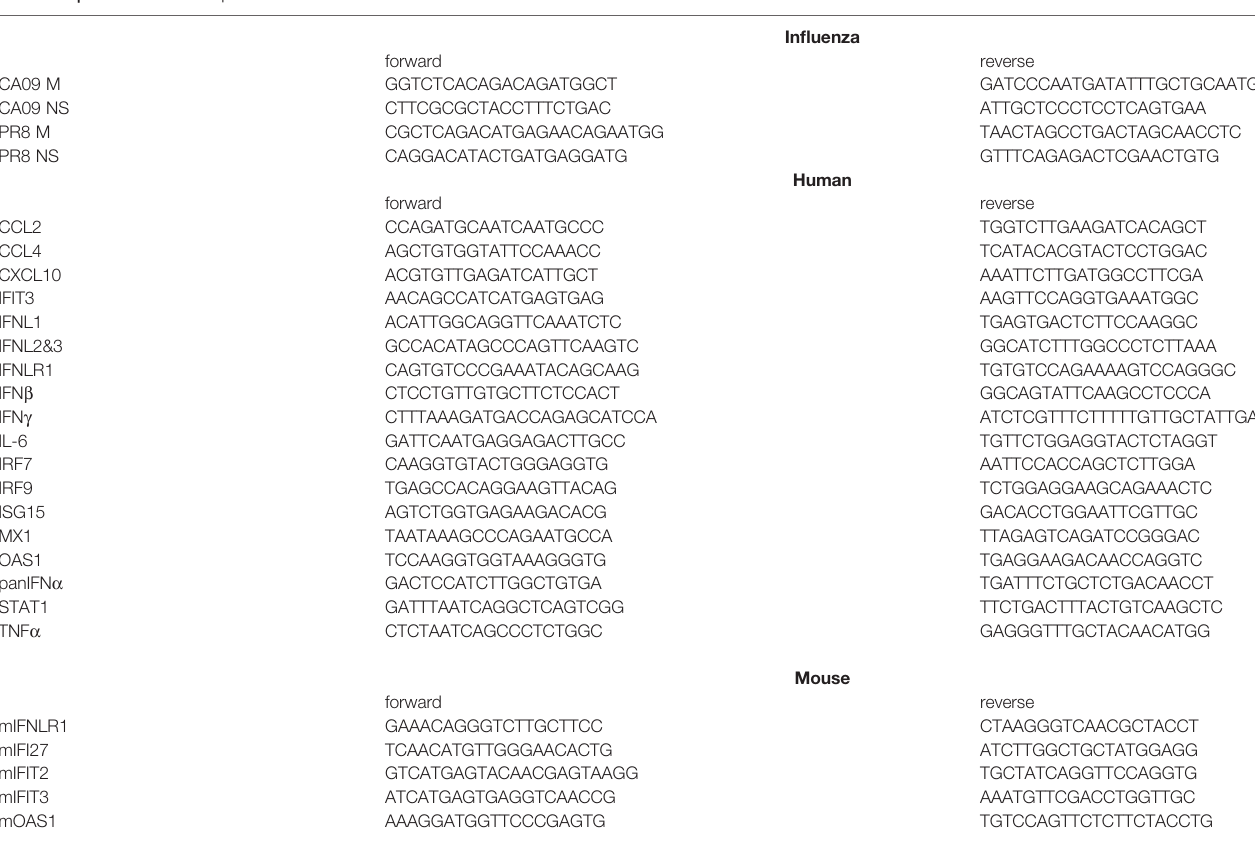
TABLE 1 | Quantitative PCR primers.